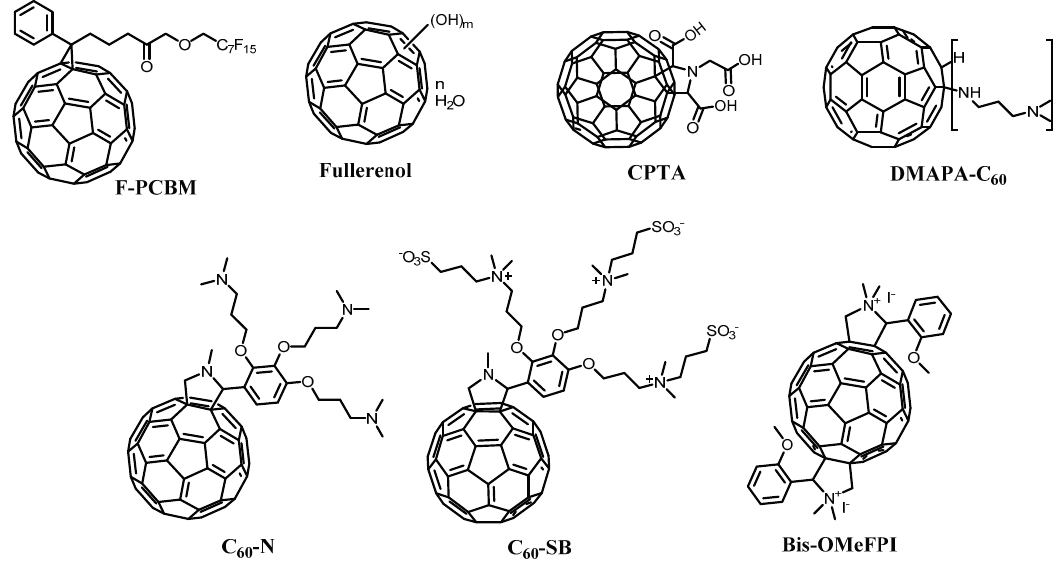
Figure 10. Chemical structures of fullerene derivative-based IFL materials F-PCBM, CPTA, DMAPA, C 60 -N, and C 60